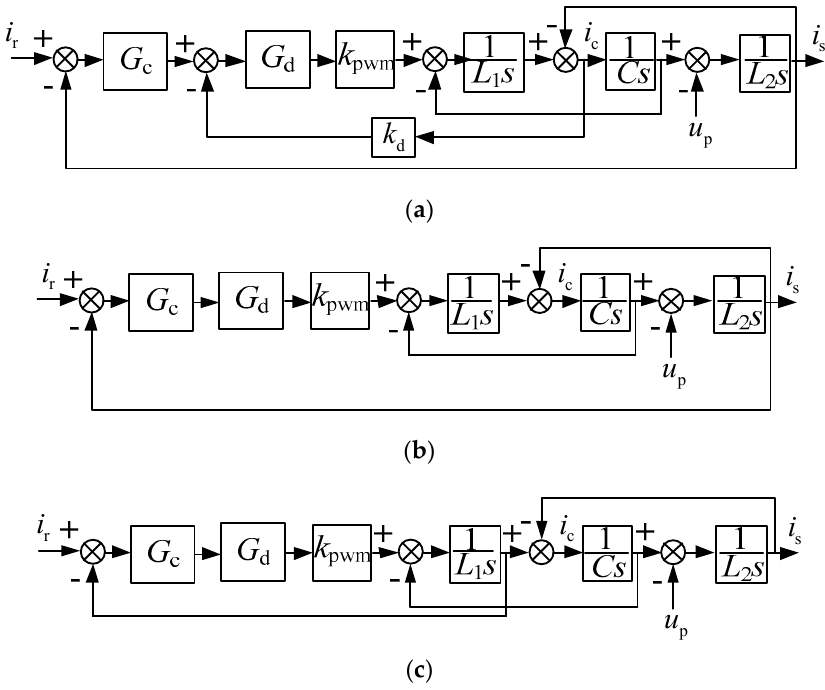
Figure 3. Inverter equivalent mathematic model in s-domain: ( a ) dual-loop control structure; ( b ) single-loop control with grid-side current feedback; ( c ) single-loop control with inverter-side current feedback.